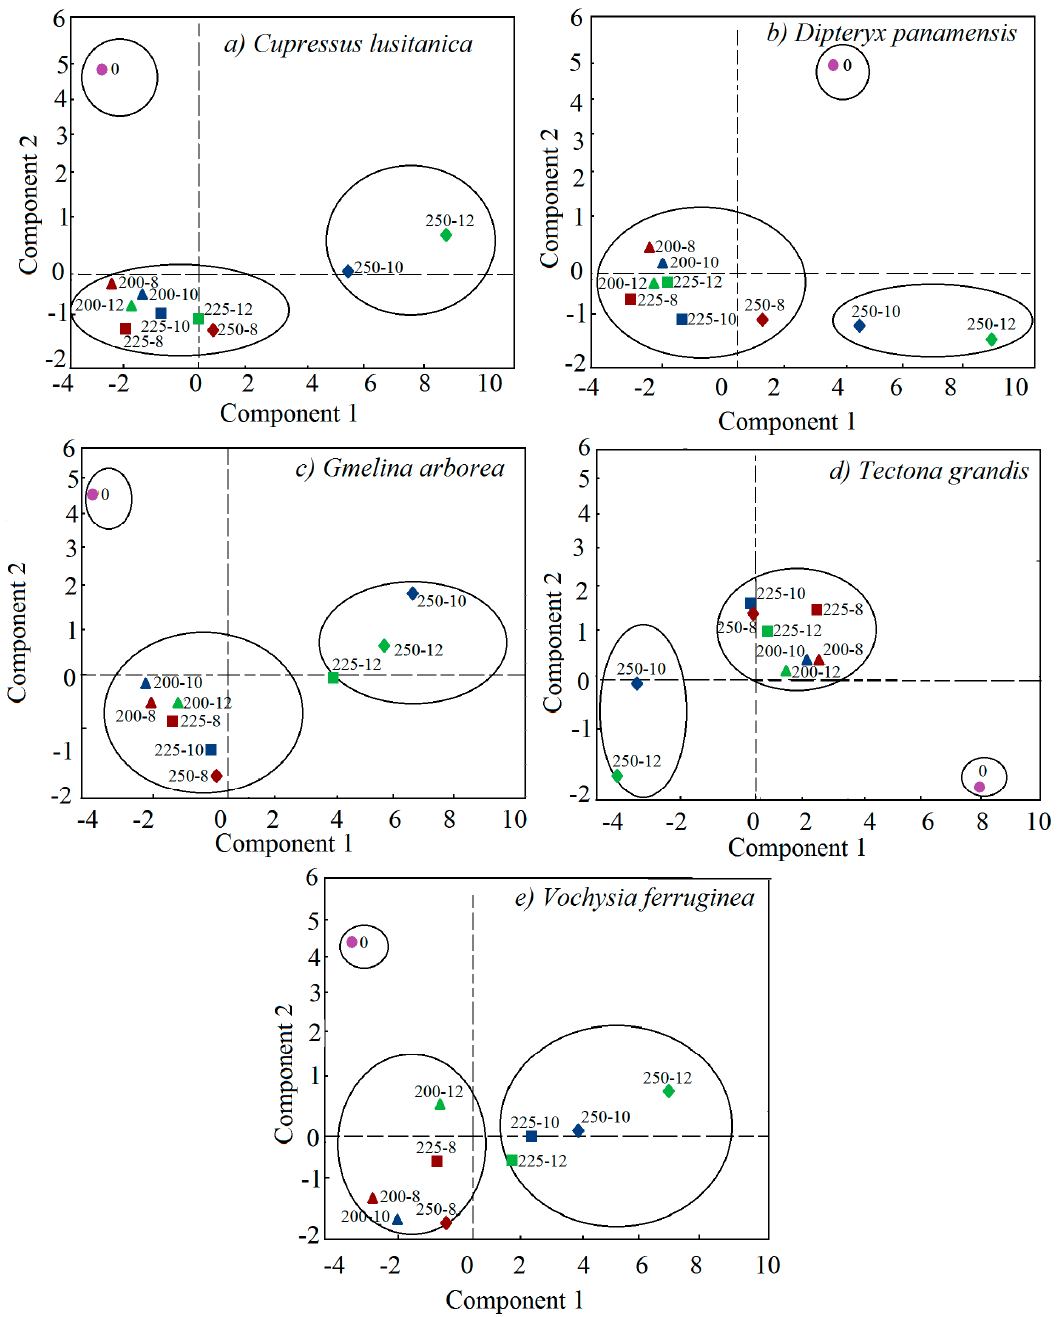
Figure 6. Relationship between the auto-vector of components 1 and 2 of the multivariate analysis by means of principal components of for Cupressus lusitanica ( a ), Dipteryx panamensis ( b ), Gmelina arborea ( c ) and Tectona grandis ( d ) and Vochysia guatemalensis ( e ), torrefied at different times and temperatures of five fast-growth plantations in Costa